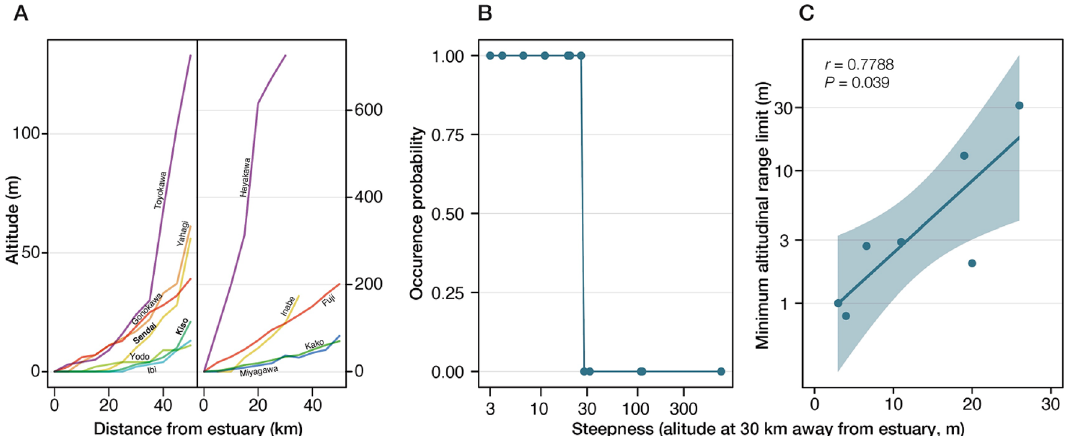
Figure 1. Altitudinal distribution of Semisulcospira reiniana . ( A ) Steepness of each river surveyed in this study. Relatively gentle and steep rivers are represented in the left and right panel, respectively. ( B ) Occupancy probability of S. reiniana by steepness in each river. ( C ) The relationship between the river steepness and the lower distribution limit of S. reiniana . Altitude at 30 km away from estuary is used as a measure of river steepness. Correlation coefficient and P -value are shown in the upper left of the